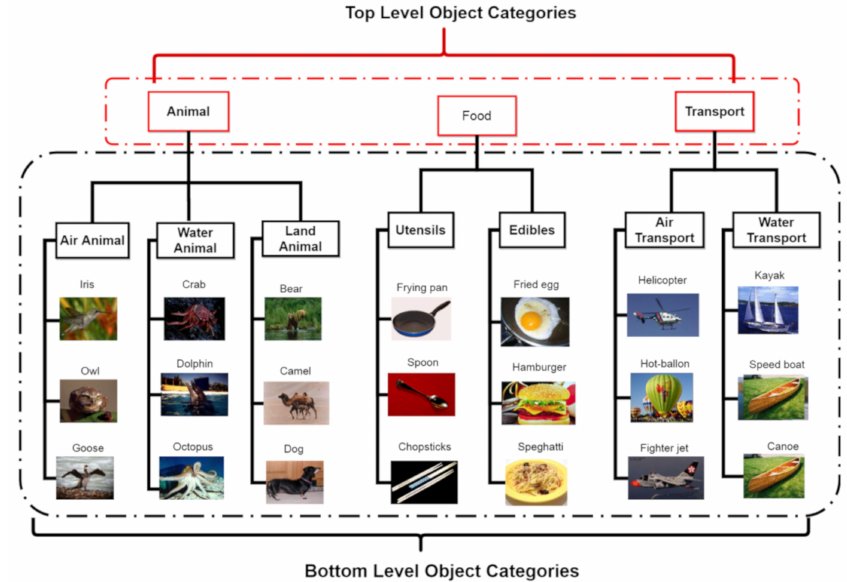
Figure 3. Caltech-256 dataset: Example images of bottom -level object categories (highlighted in black boxes), which derived from top-level object categories (highlighted in red